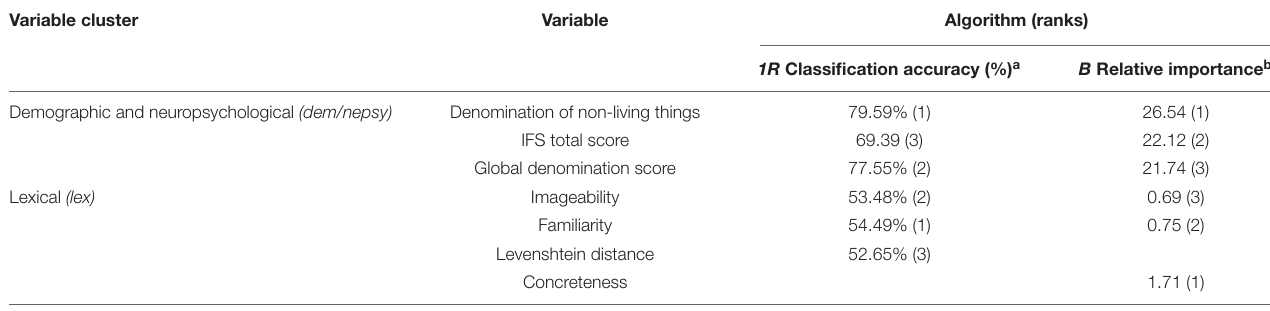
TABLE 3 | Results of the classification accuracies and variable’s